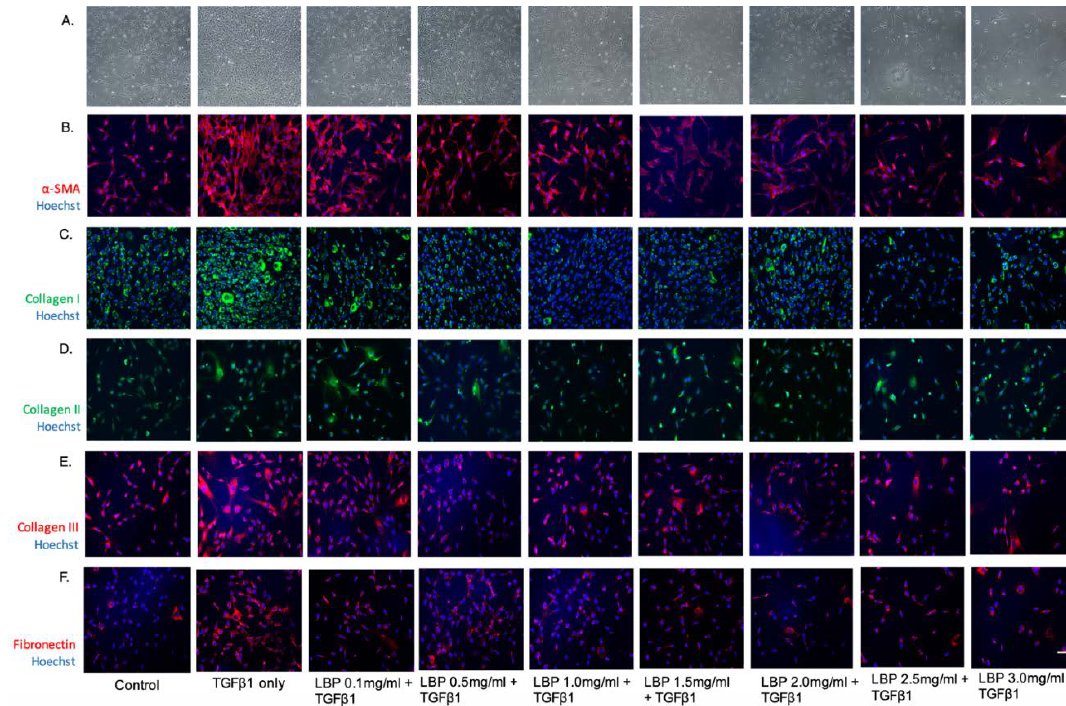
Figure 3. Immunofluorescence images showing the effect of LBP on α -SMA ( B ), collagen type I ( C ), collagen type II ( D ) and collagen type III ( E ) and fibronectin ( F ) expression along with phase contrast microscopy images ( A ). Nuclear staining was done with Hoechst 33,342 (blue). Scale bar = 100 µm.